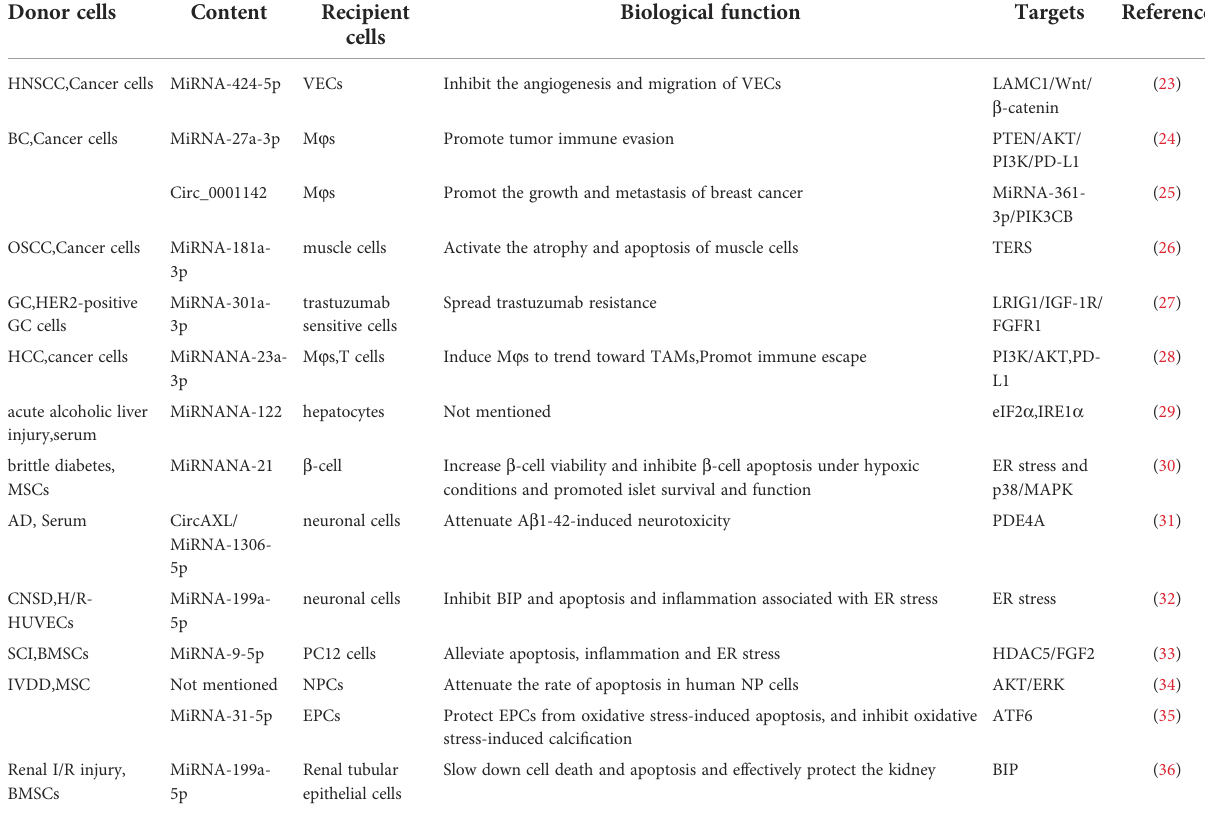
TABLE 1 The role of ER stress and EVs in different diseases (miRNA/CircRNA). Donor